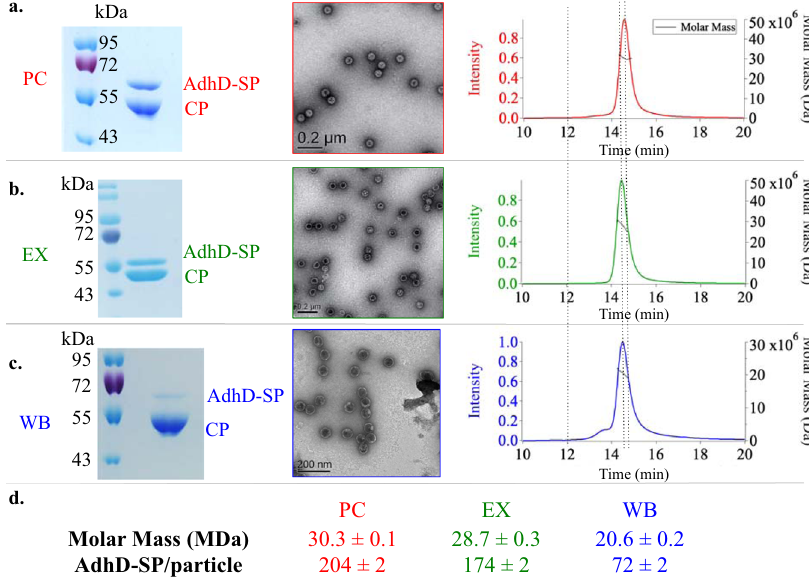
Fig. 2 Characterization of P22 VLPs. SDS-PAGE, TEM, and SEC-MALS analysis of a procapsid (PC = red), b expanded (EX = green), and c wif fl e-ball (WB = blue) morphologies. d Molar mass as determined by SEC-MALS and average number of AdhD-SP cargo molecules per P22 particle. These are representative images and chromatograms of at least 5 independent experiments for the SDS-PAGE, 20 TEM micrographs, and at least 3 for the SEC-